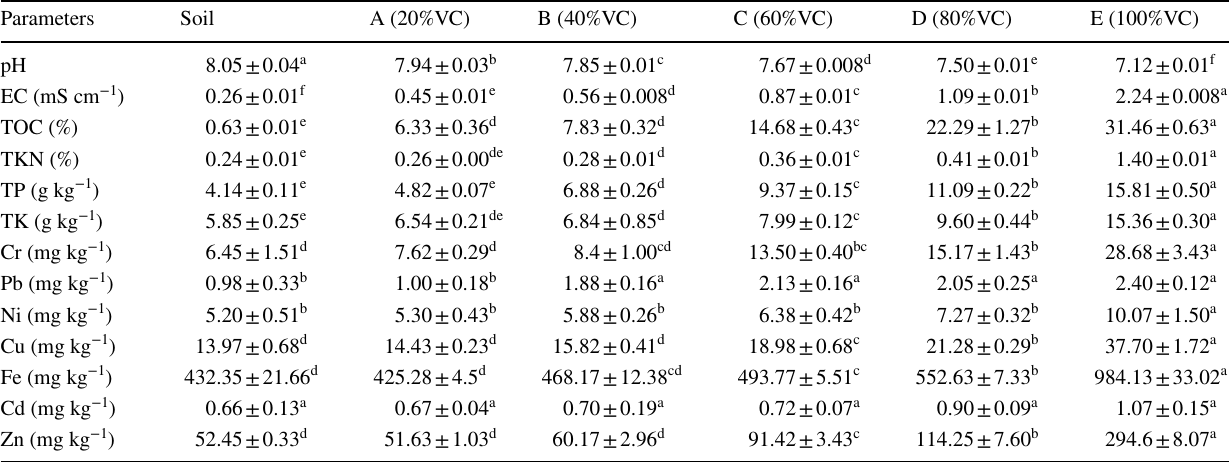
Different letters in each group show significant difference at p